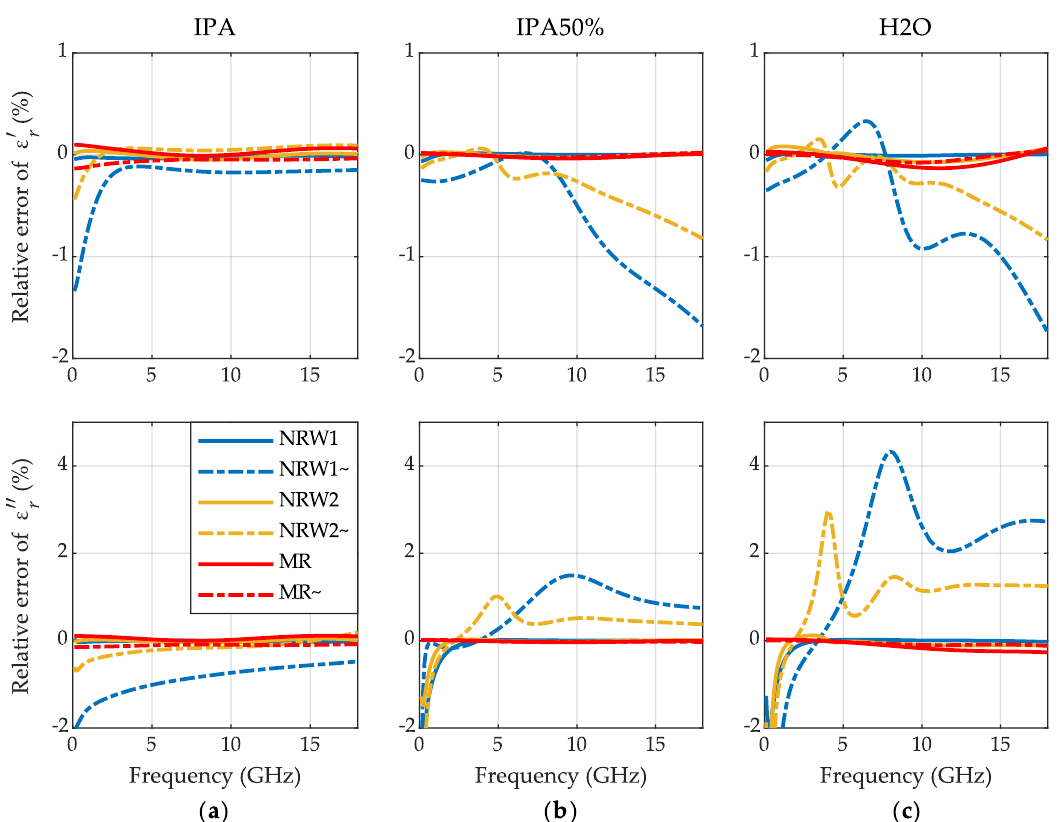
Figure 8. The relative error of the real ( ε (cid:48) r ) and imaginary ( ε (cid:48)(cid:48) r ) part of permittivity for ( a ) IPA, ( b ) 50% aqueous solution of IPA, ( c ) distilled water. Line types: solid—the ideal sample with the flat surface, dashed-dotted—the sample with the meniscus (denoted by ~). Line colors: red—the outcome of the meniscus removal (MR) method, blue and yellow—the NRW method for the initial and the final volumes of liquid,